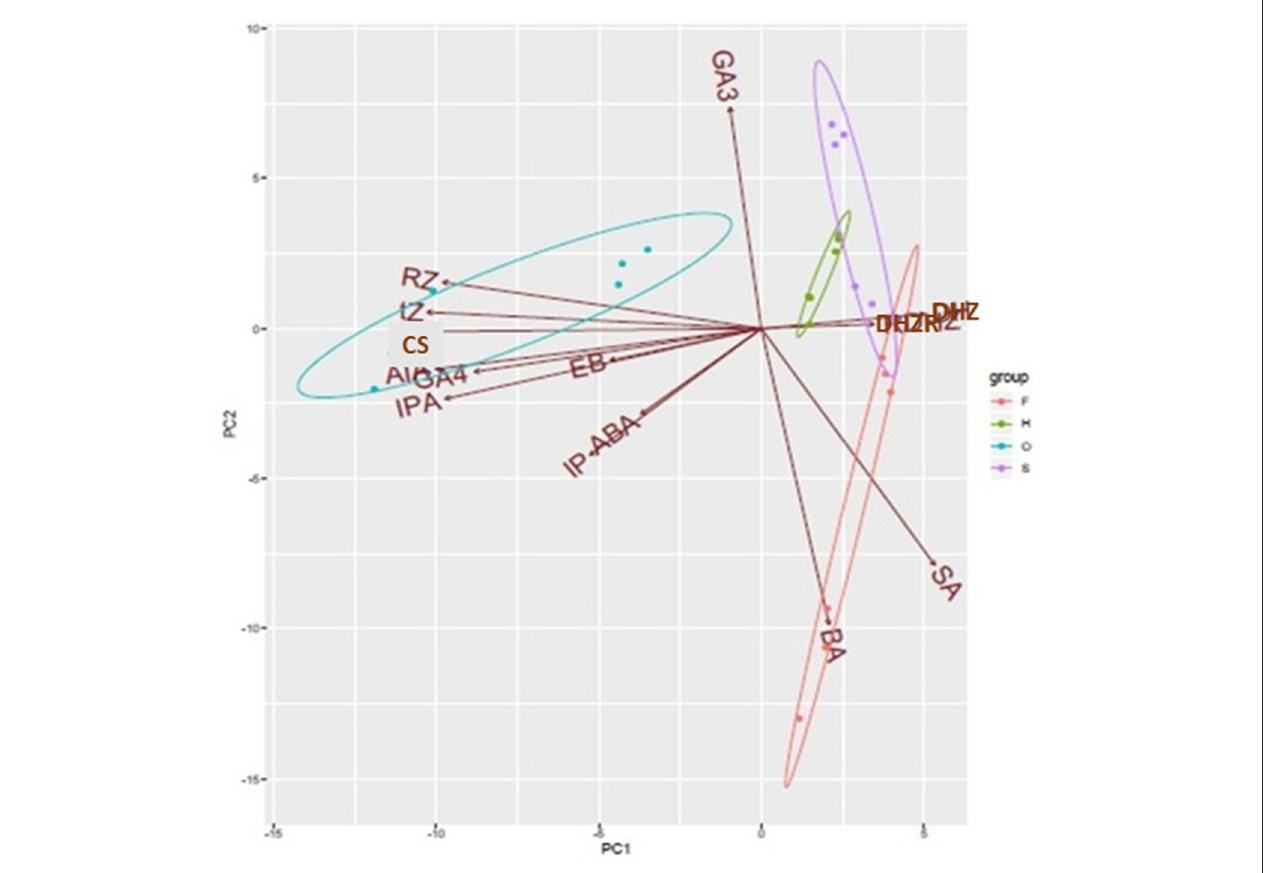
FIGURE 6 | PCA biplot showing the contribution of all variables to the variation in the endogenous content of phytohormones in filamentous (F), spatulate (S), and heart-shaped (H) gametophytes of the apogamous species Dryopteris affinis, and heart-shaped gametophytes (O) of its sexual relative D. oreades . Ellipses encircle group samples from the same origin. IAA, indol-3-acetic acid; BA, 6-benzylaminopurine; Z, trans-Zeatin; Zr, Zeatin riboside; DHZ, dihydrozeatin; DHZR, dihydrozeatin riboside; iP, isopentenyl adenine; iPR, isopentenyl adenosine; ABA, abscisic acid; SA, salicylic acid; GA 3 , gibberellic acid; GA 4 , gibberellin 4; BL, brassinolide; CS,